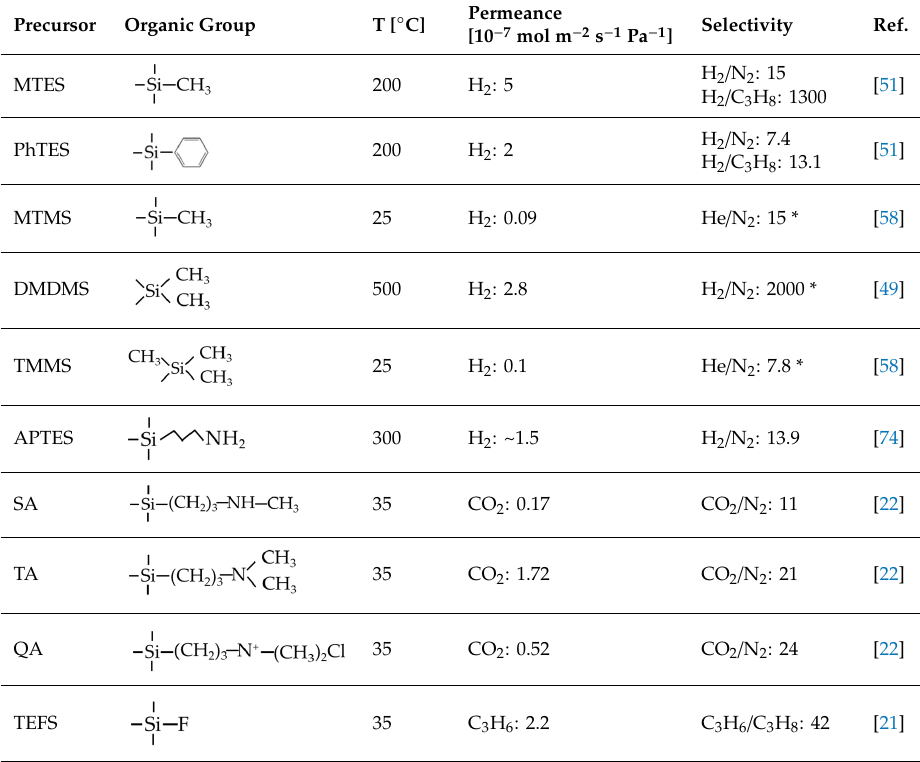
Table 4. Pendant-organosilica membranes and their performance in gas-phase separation.